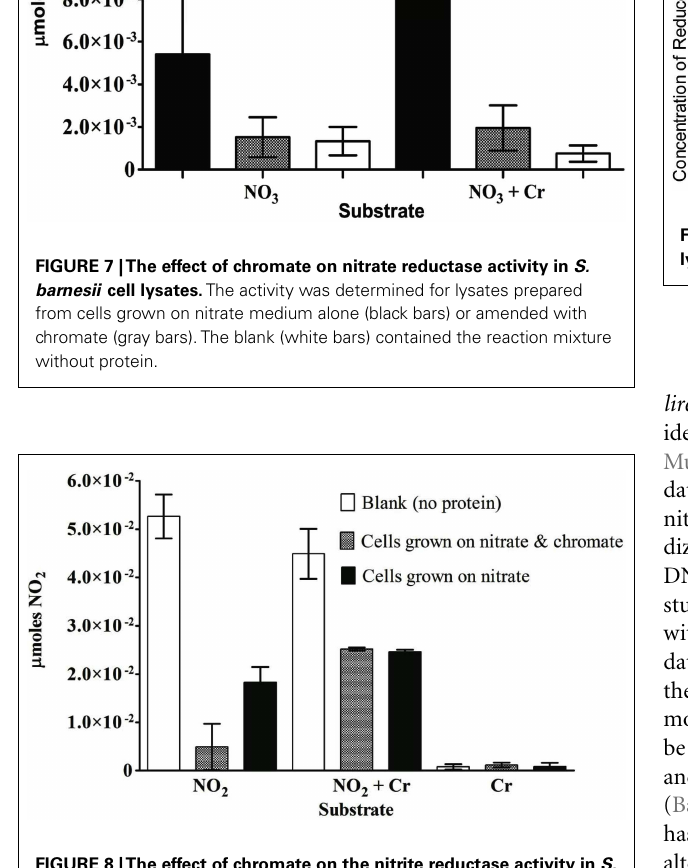
FIGURE 8 |The effect of chromate on the nitrite reductase activity in S. barnesii cell lysates. The activity was determined for lysates prepared from cells grown on nitrate medium alone (black bars) or amended with chromate (gray bars).The blank (white bars) contained the reaction mixture without protein.